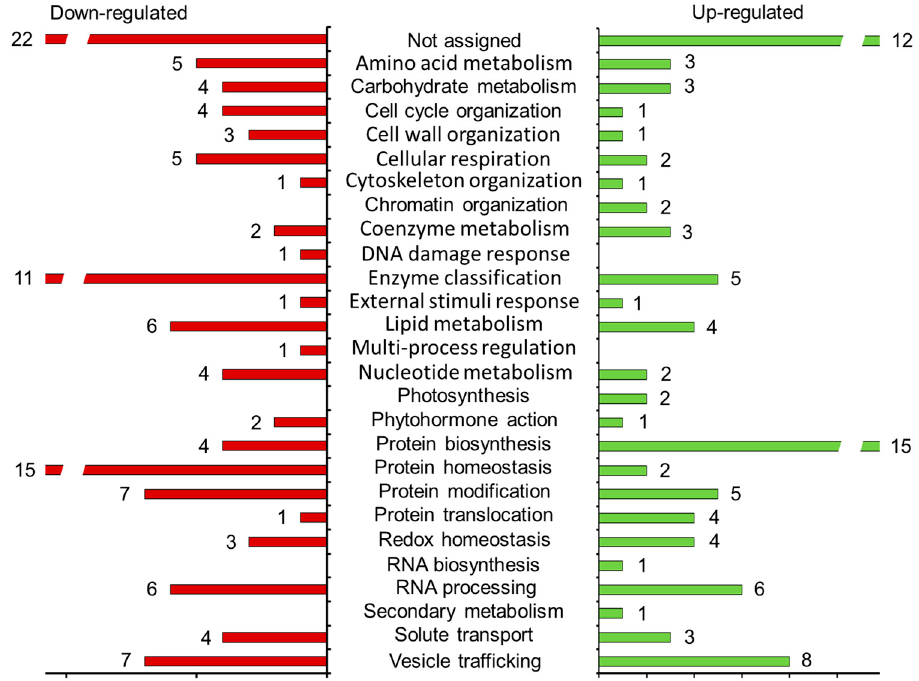
Figure 8. Functional annotation of the proteins identified as differentially abundant in Cucumis sativus transgenic roots overexpressing CsRALF34 compared with transgenic GUS control roots. Numerical values indicate the numbers of proteins constituting individual up- (green) or downregulated (red) functional classes. The individual proteins comprising each functional group (in addition to all related information) are listed in Supplementary Information S5.